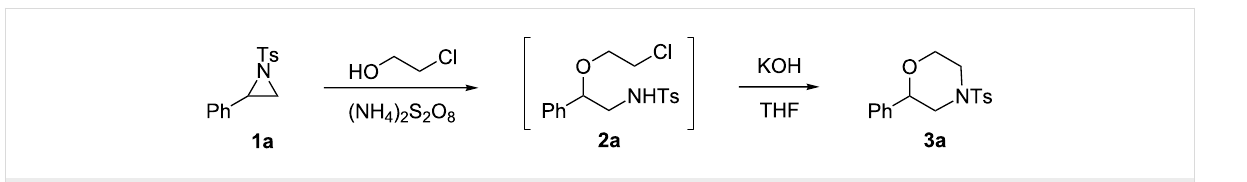
Scheme 2: Metal-free one-pot synthesis of morpholine 3a from aziridine 1a .